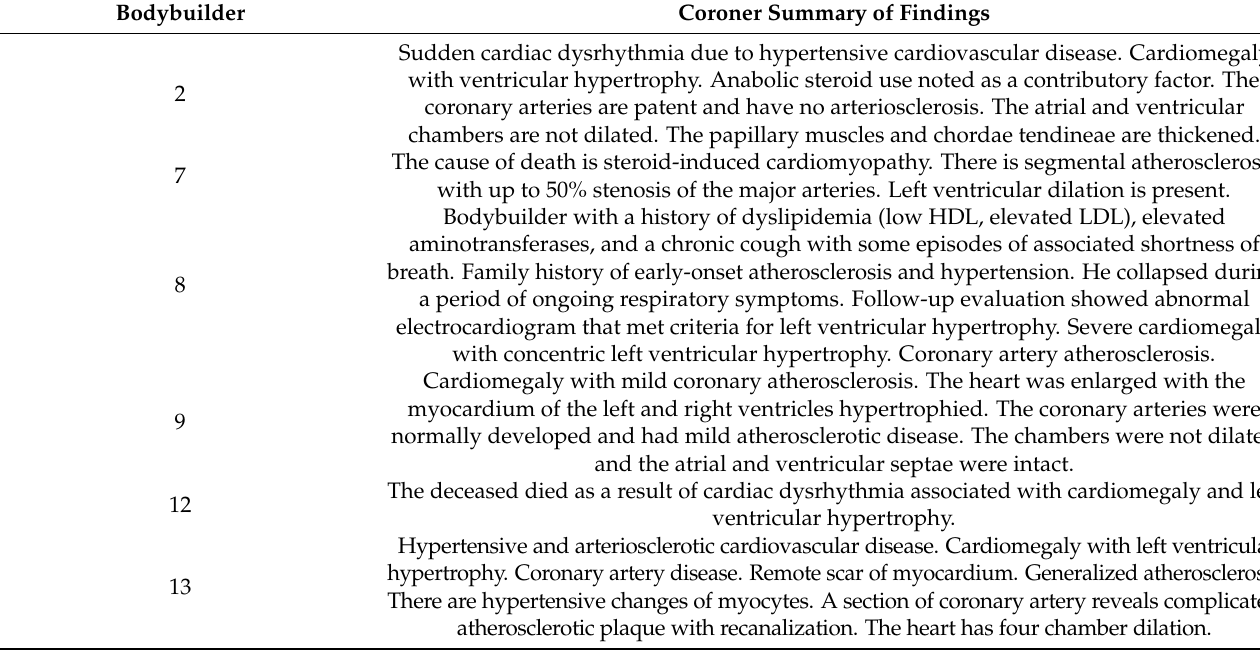
Table 4. Coroner report summary